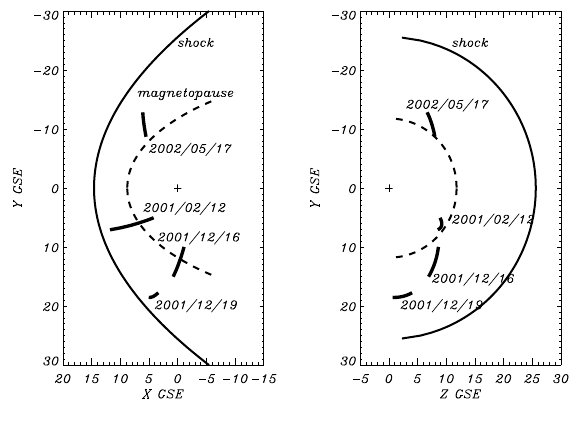
Figure1:Forthefour onsideredtimeintervals,proje tionoftheClusterorbitin